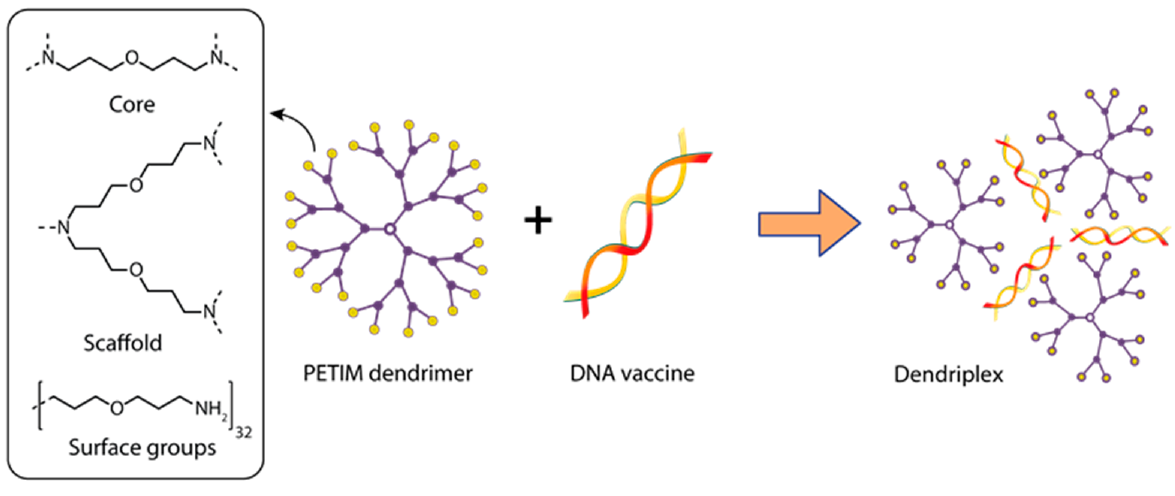
Figure 4. Constructing vaccine nanoformulations based on PETIM dendrimers .